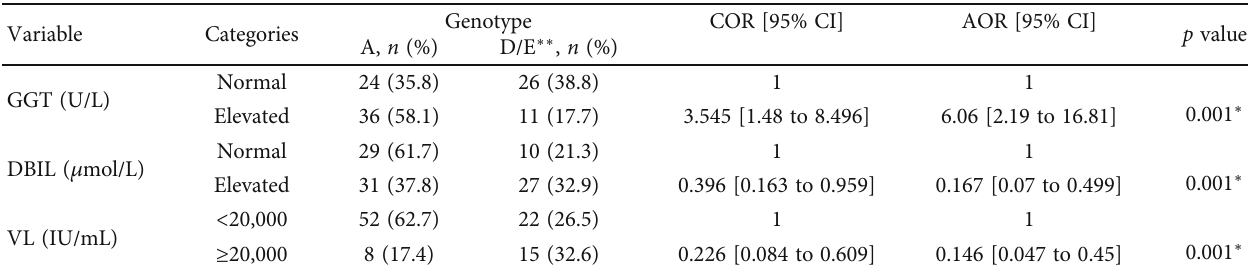
Table 6: Analysis of the variation in the levels of GGT, DBIL, and VL with genotype A using multinomial logistic regression analysis. Variable